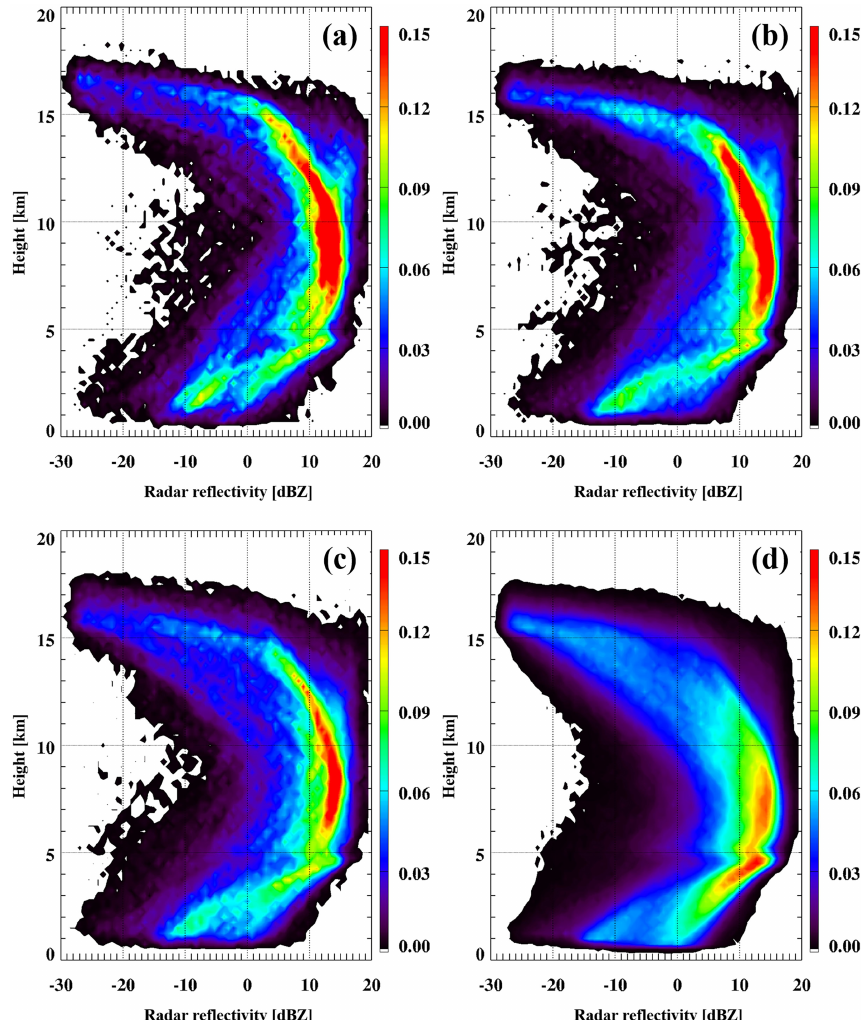
Figure 3. Two-dimensional histograms of radar reflectivity profiles for DCCs observed over (a) African, (b) South American, (c) western Pacific (land), and (d) western Pacific (ocean) domains. The color bars represent probability with respect to the total